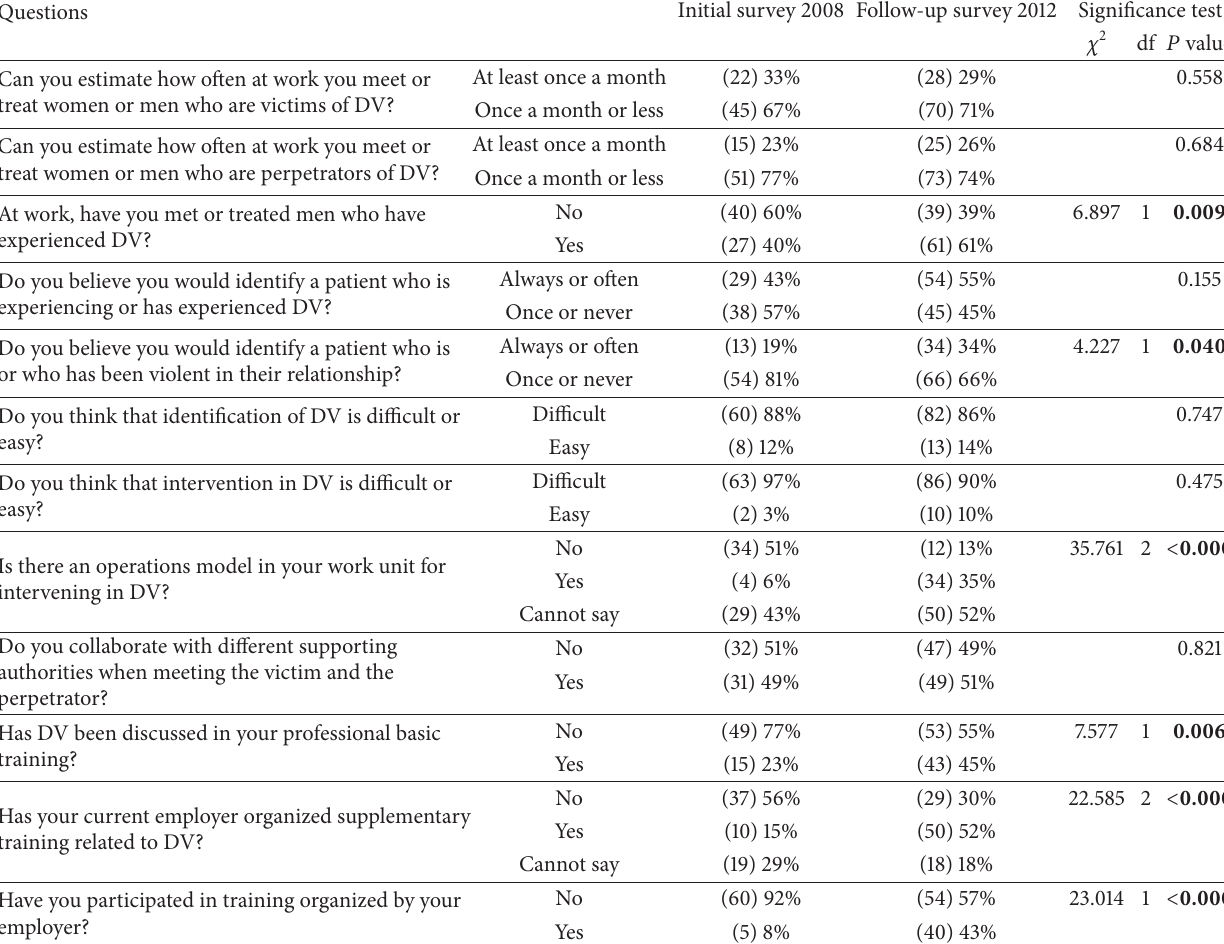
Table 2: Changes of opinions of the respondent groups to manage